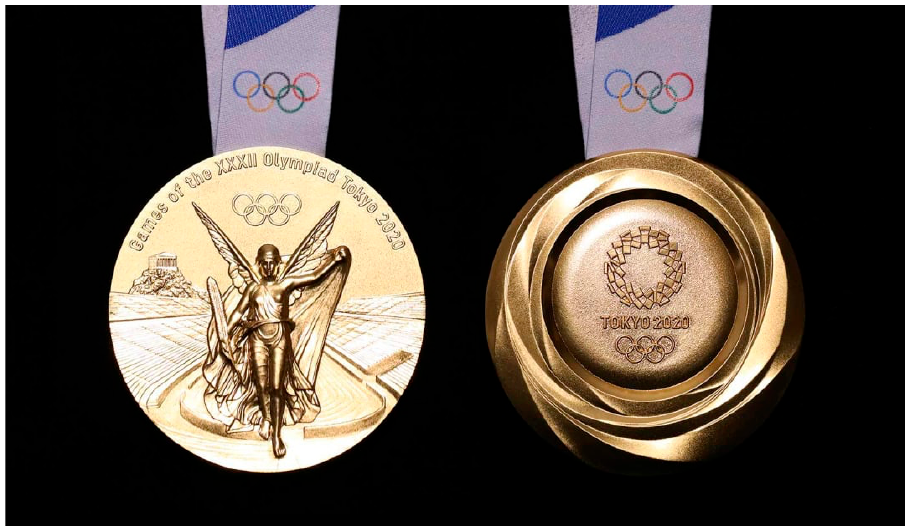
Figure 7. Gold medal of the 2020 Summer Olympics in Tokyo. Reproduced with permission from IOC. Image source: “Tokyo 2020 Olympic Medal Design,” Tokyo 2020, https://olympics.com/tokyo- 2020/en/games/olympics-medals-design/ (accessed on 28 August 2021).